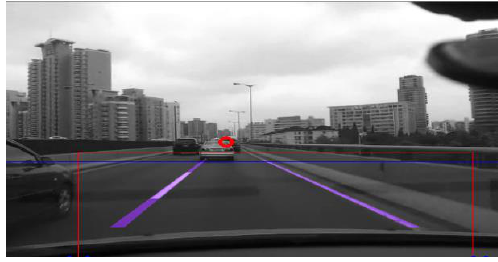
Fig 5. The diagram of vanishing point